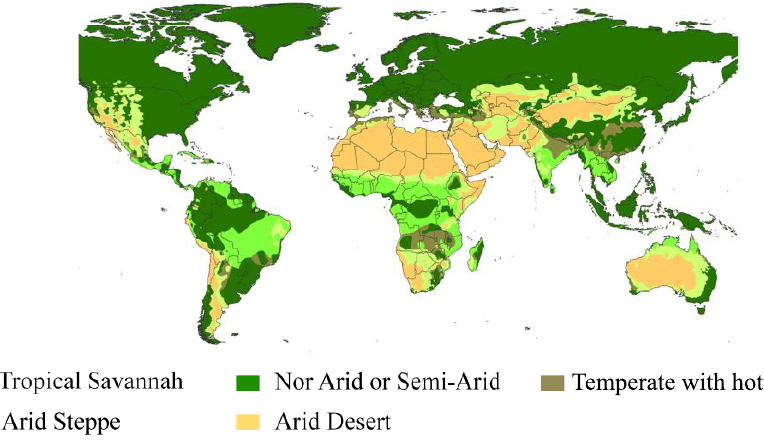
Figure 1. Climate classes for arid and semi-arid climates: tropical savannah, arid steppe, arid desert, temperate with hot dry seasons, and all others (Nor arid or semi-arid) [11].